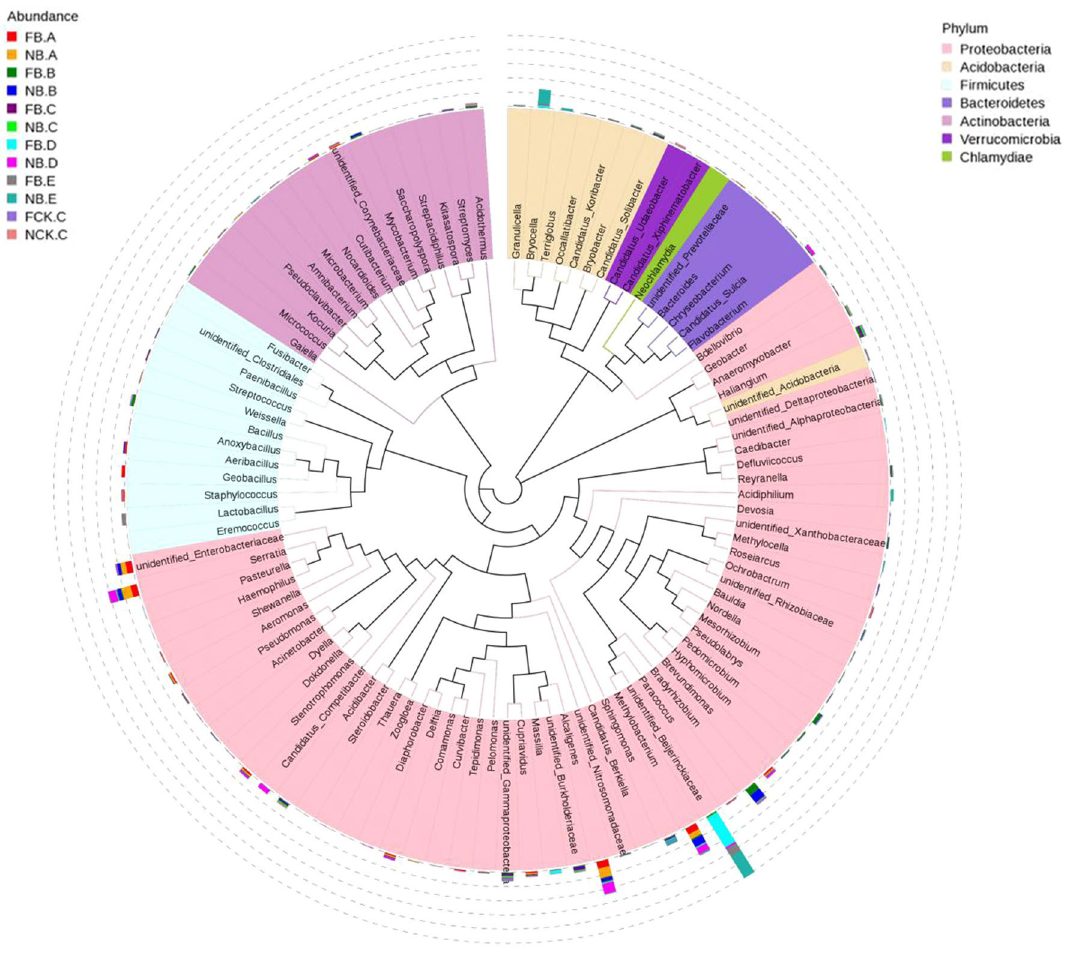
Figure 5. Top OTU members of the bacterial microbiome associated with the plant niches. Taxonomic dendrogram showing the core bacterial microbiome of each plant compartment. Color ranges identify genera within the